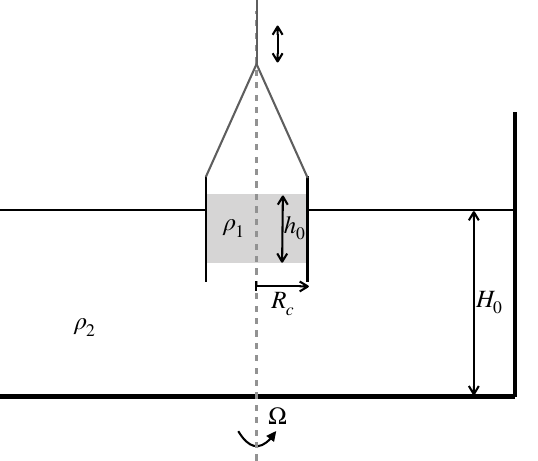
Figure 2. Schematics of the laboratory experiment setup, showing the rotating tank and the inner cylinder with lighter fluid inside, before